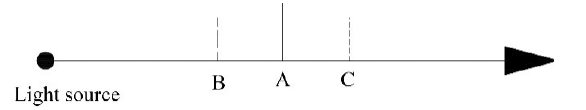
Fig. 3. Schematic of positioning inaccuracy.